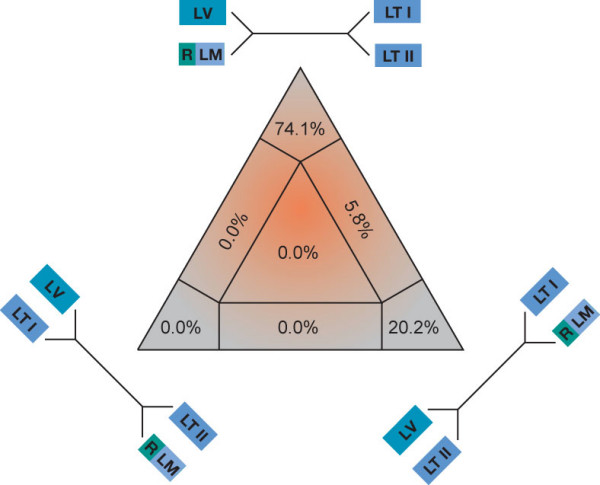
Four-cluster likelihood mapping analysis. The topology with a monophyly of the two endemic Tanganyikan clades receives the highest support. LM, Lake Malawi (S. njassae); LT I, first Lake Tanganyika clade; LT II, second Lake Tanganyika clade; LV, Lake Victoria (S. victoriae); R, riverine representatives.